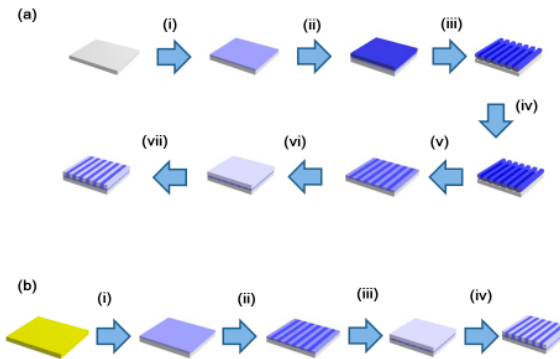
Figure 1. ( a ) Schematic presentation of block copolymer lamella orientation process using a conventional chemically patterned surface. (i) self-assembled monolayer (SAM) coating on Si. (ii) resist coating. (iii) Resist was exposed and developed. (iv) SAM was patterned in the presence of O 2 though resist mask (v) Resist was removed and surface neutrality. (vi) Block copolymer was spin-coated. (vii) Block copolymer was self-assembled to match underlying SAM patterns. ( b ) Schematic presentation of block copolymer lamella orientation process using a directly chemically patternable SAMs method. (i) SAM coating on Si. (ii) SAM was directly patterned by EB. (iii) Block copolymer was spin-coated. (iv) Lamella orientation of block copolymer was self-assembled in underlying SAM patterns.